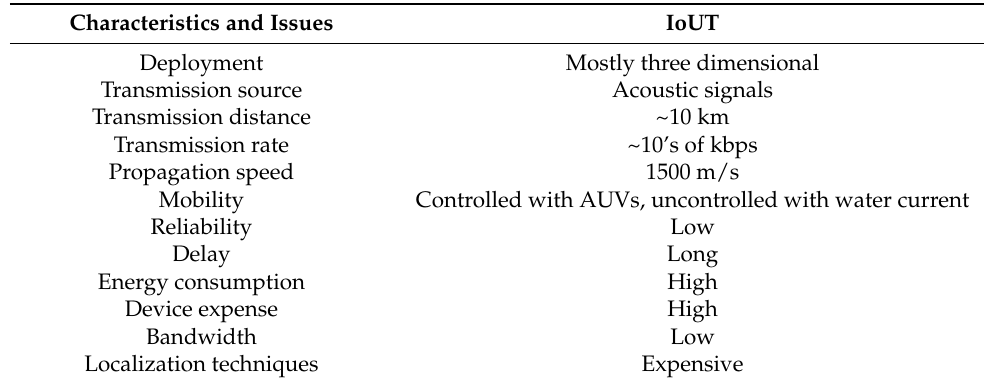
Figure 3. Organization of this study. Table 1. IoUT Characteristics and Issues